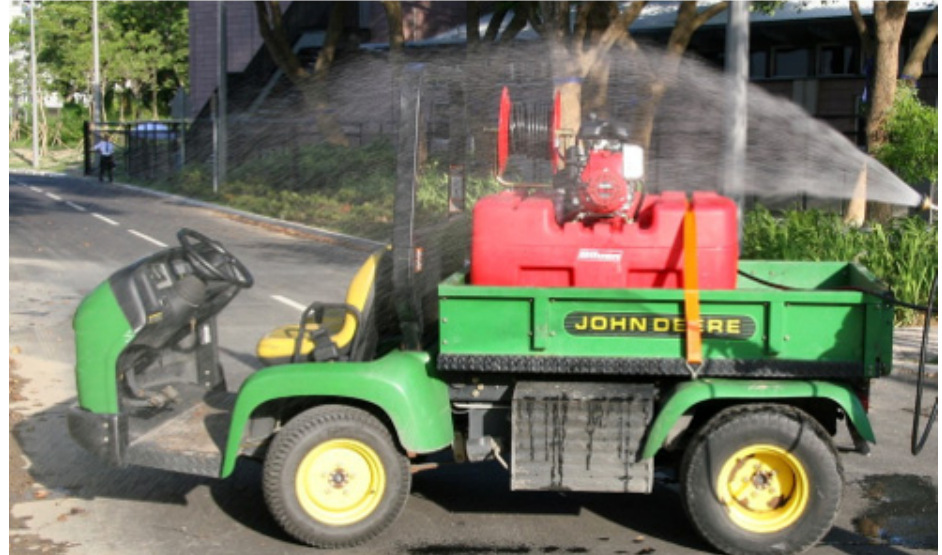
Figure 22. A cold-water spray unit in use at the Hong Kong Jockey Club.